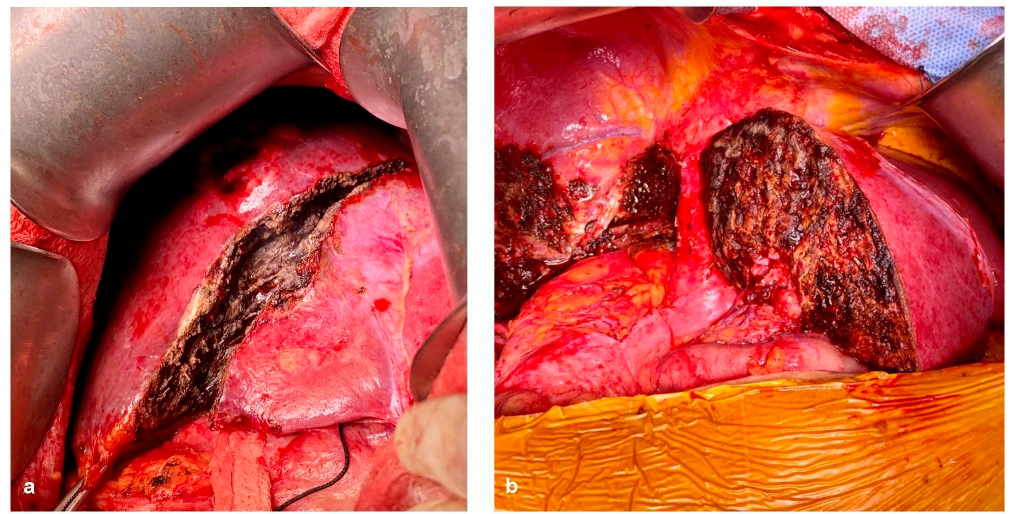
Figure 4. Second stage of a Mini-ALPPS in the patient previously described in Figure 3. ( a ) Ten days after a successful first stage, a conventional second stage was performed. Transection line and the deportalized right lobe can be observed. ( b ) Completion of the second stage with the cut edge of the FLR with neithr signs of bleeding nor bile leak.